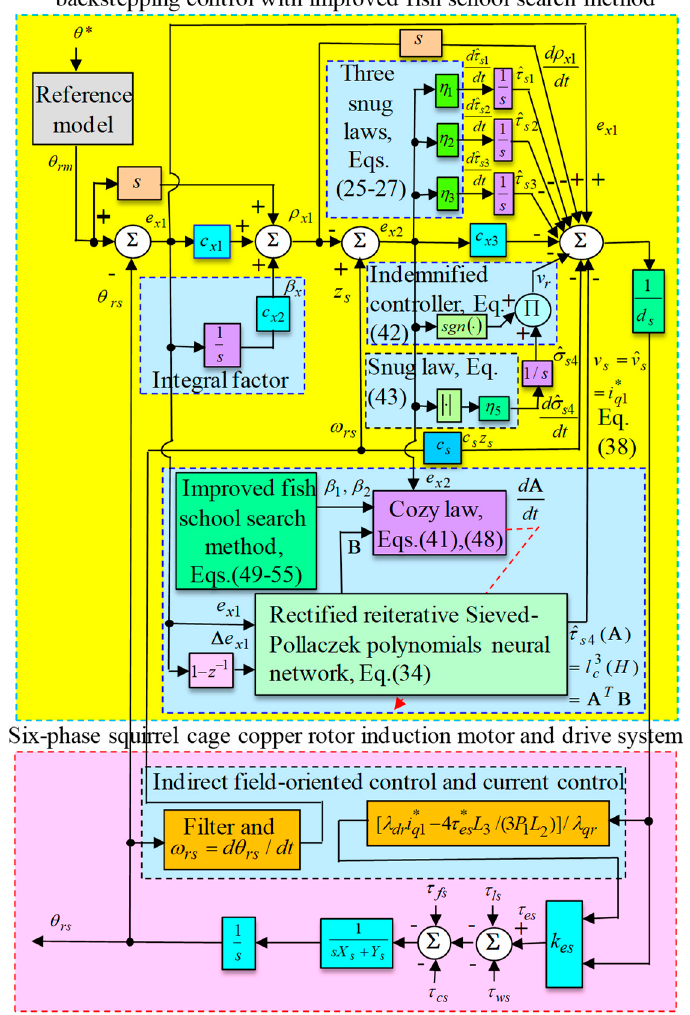
Figure 5. Control block diagram of the proposed rectified reiterative sieved-Pollaczek polynomials neural network backstepping control with improved fish school search method.